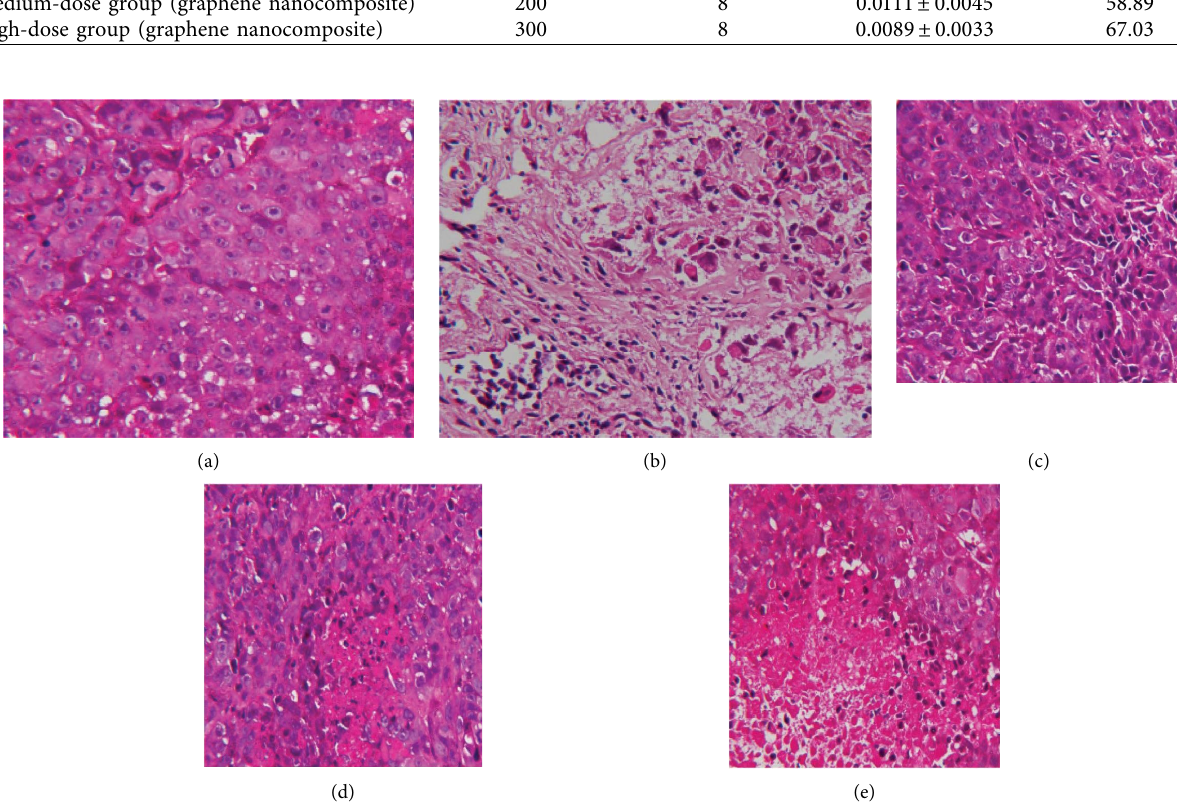
Figure 7: HE staining of nude mice tumor in diferent treatment groups. (a) Nude mice tumors in the control group (200 μ g/saline, × 200), (b) nude mice tumors in the CDDP group (200 μ g/CDDP, × 200), (c) nude mice tumors in the experimental group (100 μ g/graphene carrier complex, × 200); (d) nude mice tumors in the experimental group (200 μ g/graphene carrier complex, × 200), (e) nude mice tumors in the experimental group (300 μ g/graphene carrier complex, ×